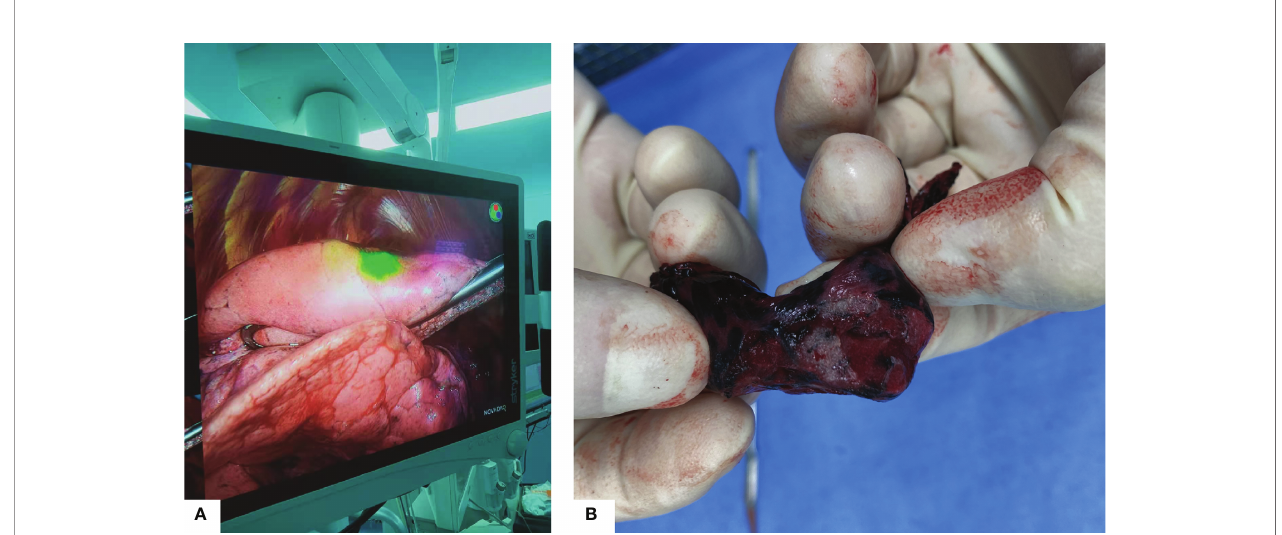
FIGURE 2 | (A) Intraoperative fl uorescence using near-infrared thoracoscope, the nodule was localized in the green light area. (B) Gross appearance of the resected